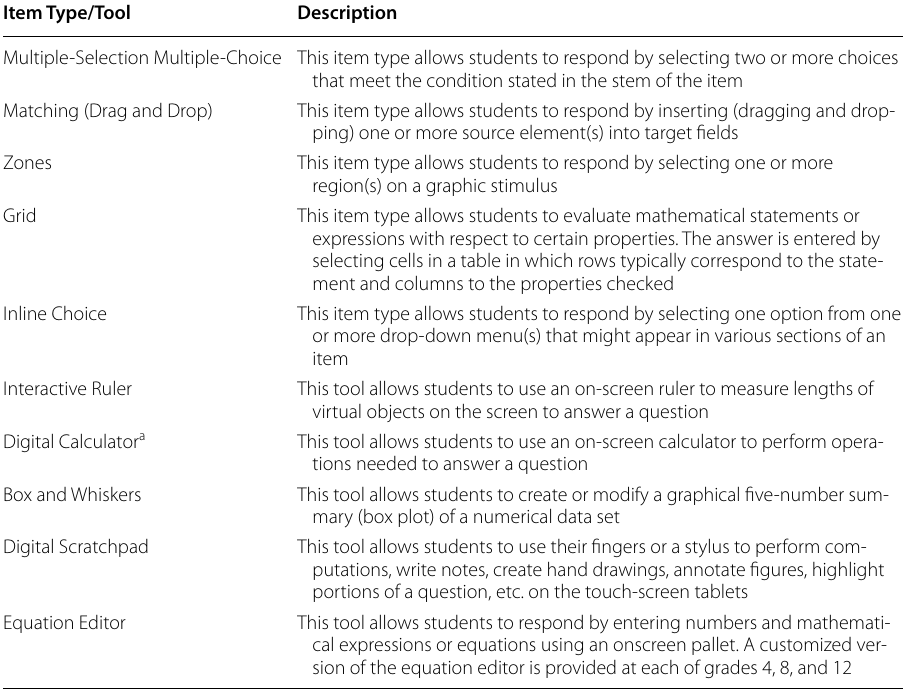
a A digital four‑function calculator was available for a selected set (approximately 1/3) of the items within one administration at Grade 4. A digital scientific calculator was available for a selected set (approximately 1/3) of the items within one administration at Grade 8 and Grade